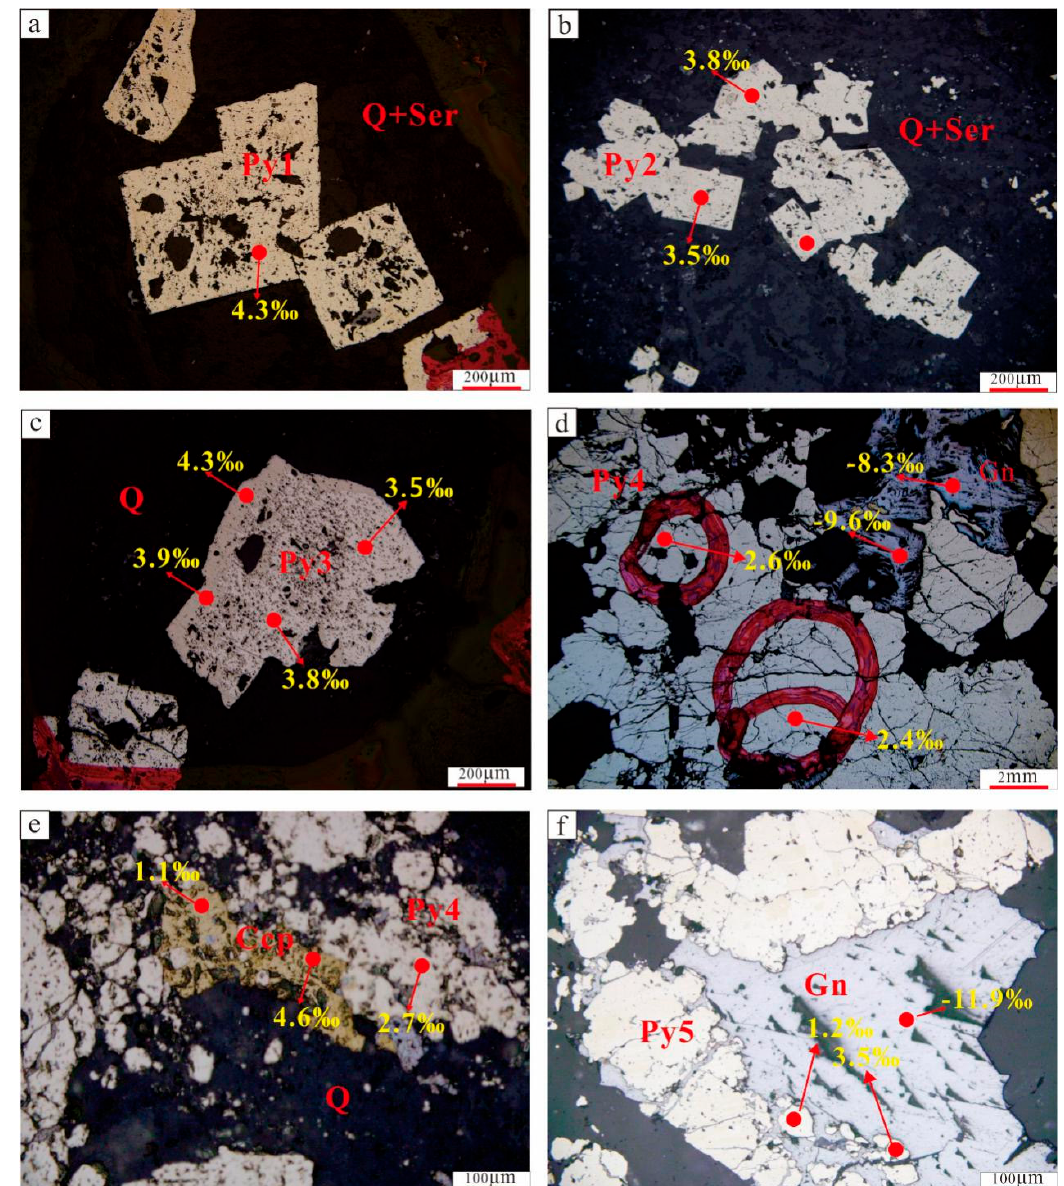
Figure 6. Reflected light photomicrographs showing sulfide minerals in the Liyuan gold deposit. ( a ) Coarse-grained pyrite (Py1) with rich mineral inclusions in the early-stage pyrite–sericite–quartz rocks; ( b ) medium-grained and euhedral pyrite (Py2) with minor/no mineral inclusions in the early-stage pyrite–sericite–quartz rocks; ( c ) pyrite (Py3) showing distinct zoning structure with an inclusion-rich core overgrown by a clean rim; ( d ) middle-stage pyrite (Py4) showing cataclastic texture and microfractures; ( e ) characteristics of a paragenetic relationship between fragmented pyrite (Py4) and chalcopyrite; and ( f ) Pyrite (Py5) replaced by galena in the middle stage. Mineral abbreviations: Py, pyrite; Gn, galena; Ccp, chalcopyrite; Qtz, quartz; Ser, sericite; and XX ‰ , the value of δ 34 S.